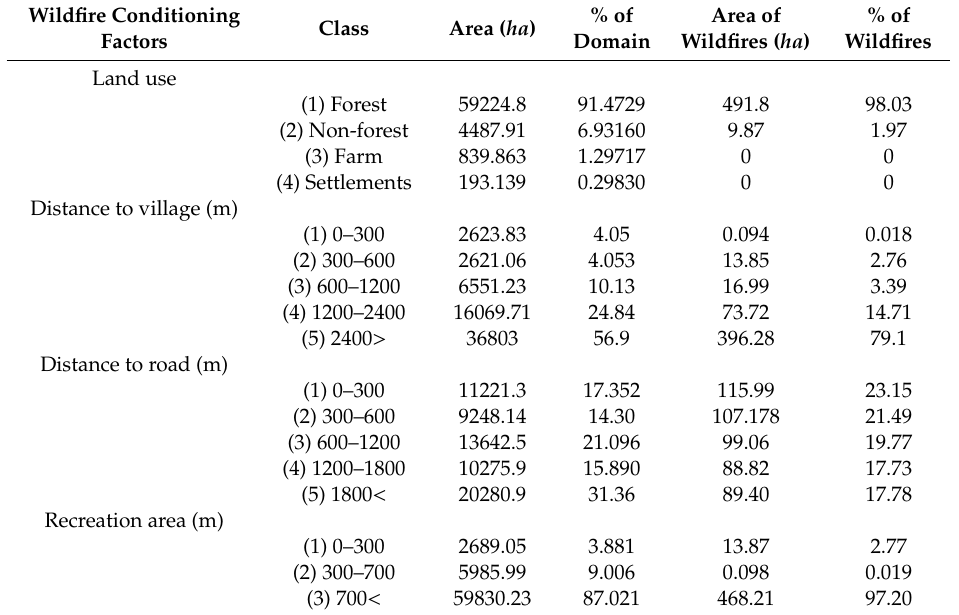
Table 4. The anthropological factors, the area of classes, and percent of the wildfire-a ff ected areas in each class.